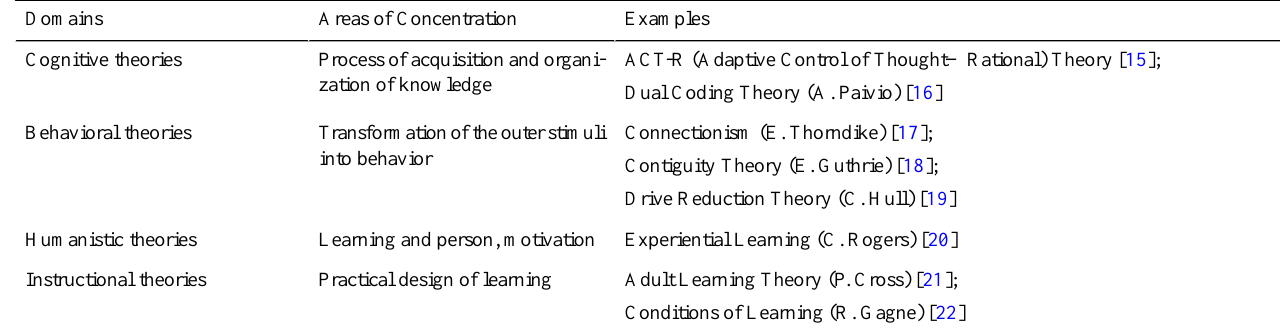
Table 1. Learning theories used in the design of the web-based educational program ExamplesAreas of ConcentrationDomains ACT-R (Adaptive Control of Thought—Rational) Theory [15]; [16]Process of acquisition and organi- knowledgeCognitive theories zation of Dual Coding Theory (A. Paivio) Connectionism (E. Thorndike)